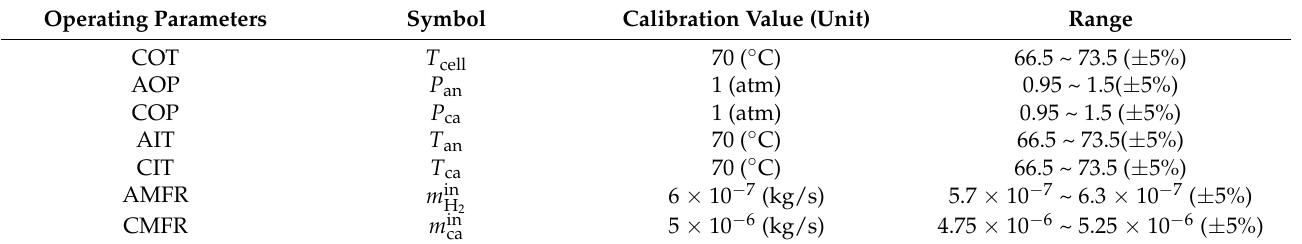
Table 4. Calibration parameters and the fluctuation ranges.